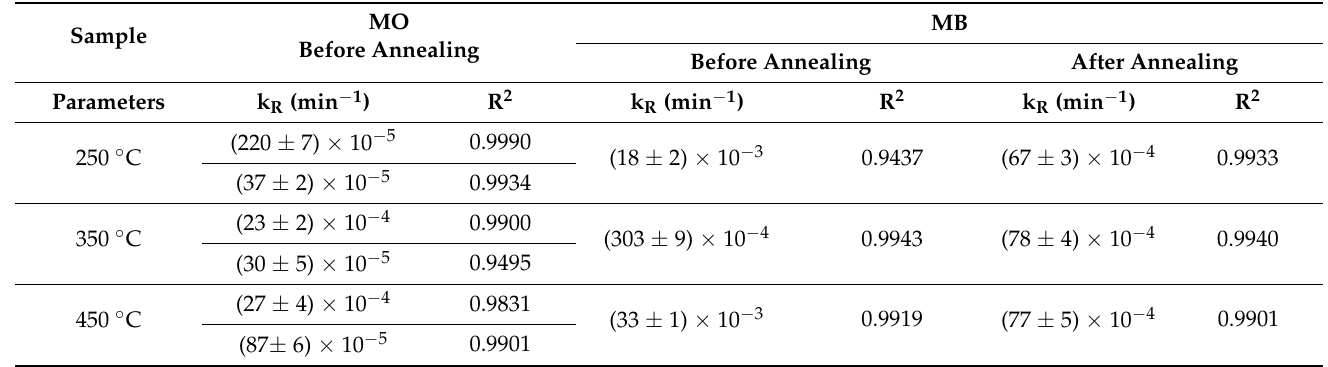
Table 2. Kinetic rate constants and statistical parameters of photodegradation of MB and MO using MOCVD TiO 2 films before and after annealing at 500 ◦ C for 2